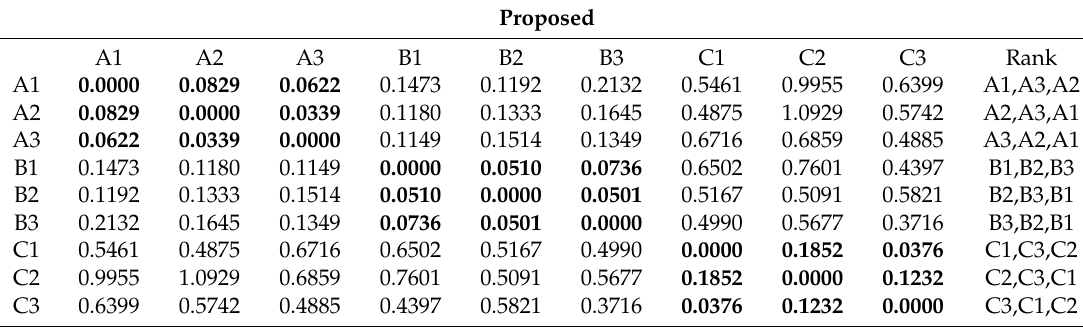
Table 12. The performance of the proposed index for the ROSIS